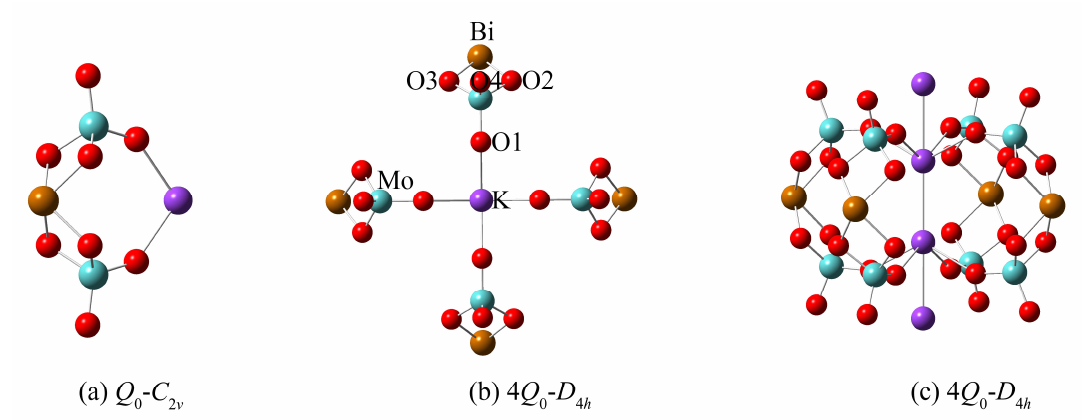
Figure 5. ( a ) The designed structural units and ( b , c ) the corresponding multi-molecular clusters structure for the ab initio calculation of molten Raman spectra of KBi(MoO 4 ) 2 . Here, ( b , c ) represent the same cluster structure containing four molecules viewed from the in-plane and out-of-plane directions. The elements are labeled (Mo, light blue; K, violet; Bi, light brown; O, red) in the diagram of ( b